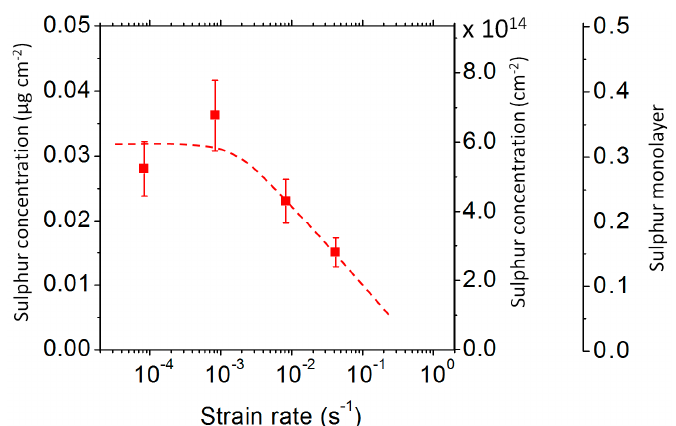
Figure 7. The sulphur concentration measured using wavelength-dispersive spectroscopy (WDS) on Figure 7: The sulphur concentration measured using wavelength ‐ dispersive spectroscopy (WDS) on the fracture surface of the 9 ppm S specimens, tensile tested at 850 ◦ C at di ff erent strain the fracture surface of the 9 ppm S specimens, tensile tested at 850 °C at different strain rates.